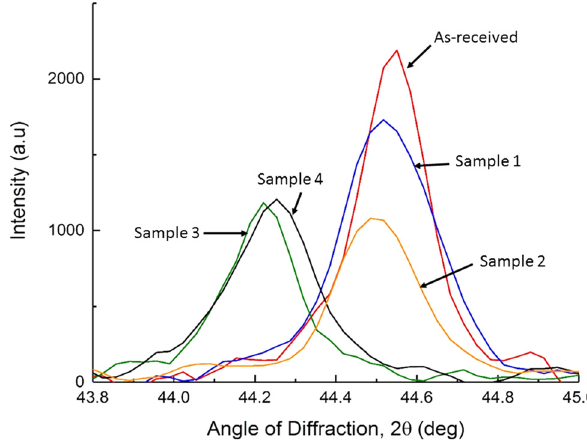
Figure 7: XRD phase analysis of the as - received and machined surface under various cutting conditions.